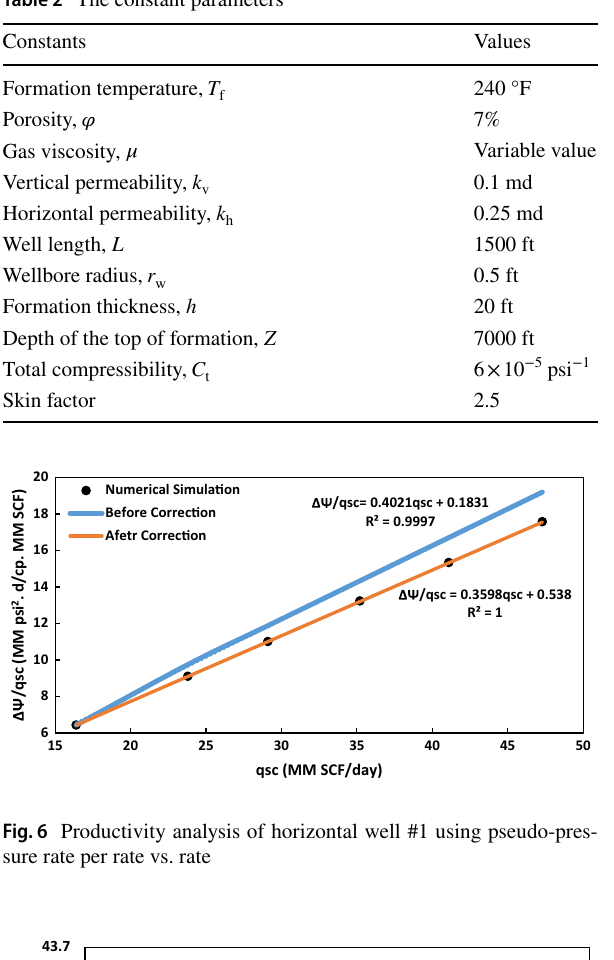
Fig. 9 The impact of skin factor on the error between pseudo-pres- sure before and after